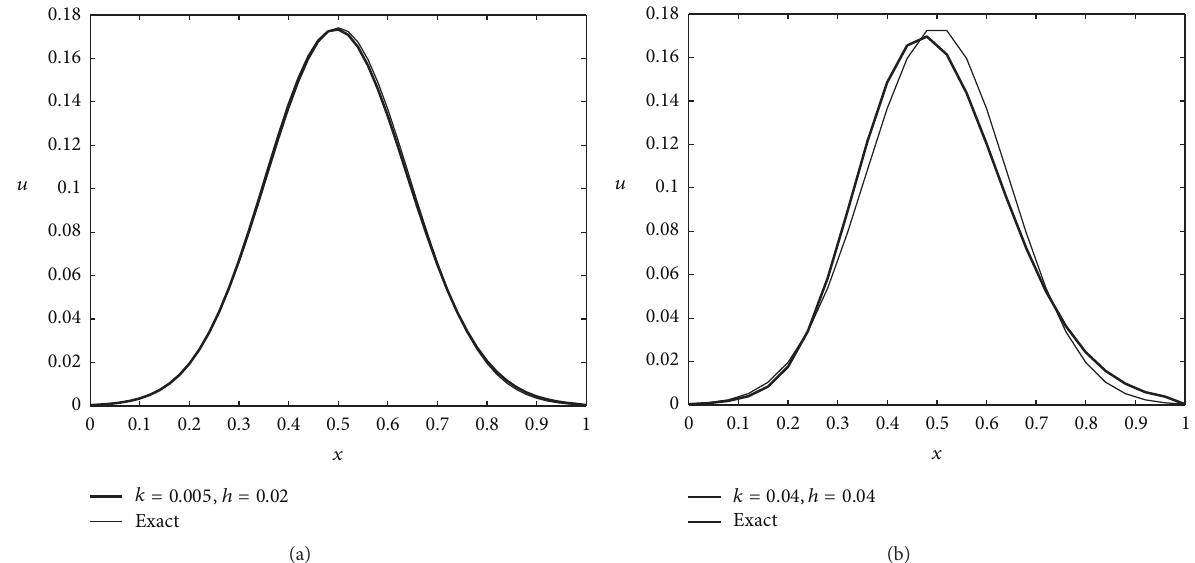
Figure 5: Comparison of numerical results with exact results using Crank-Nicolson scheme at some values of 𝑘 and ℎ